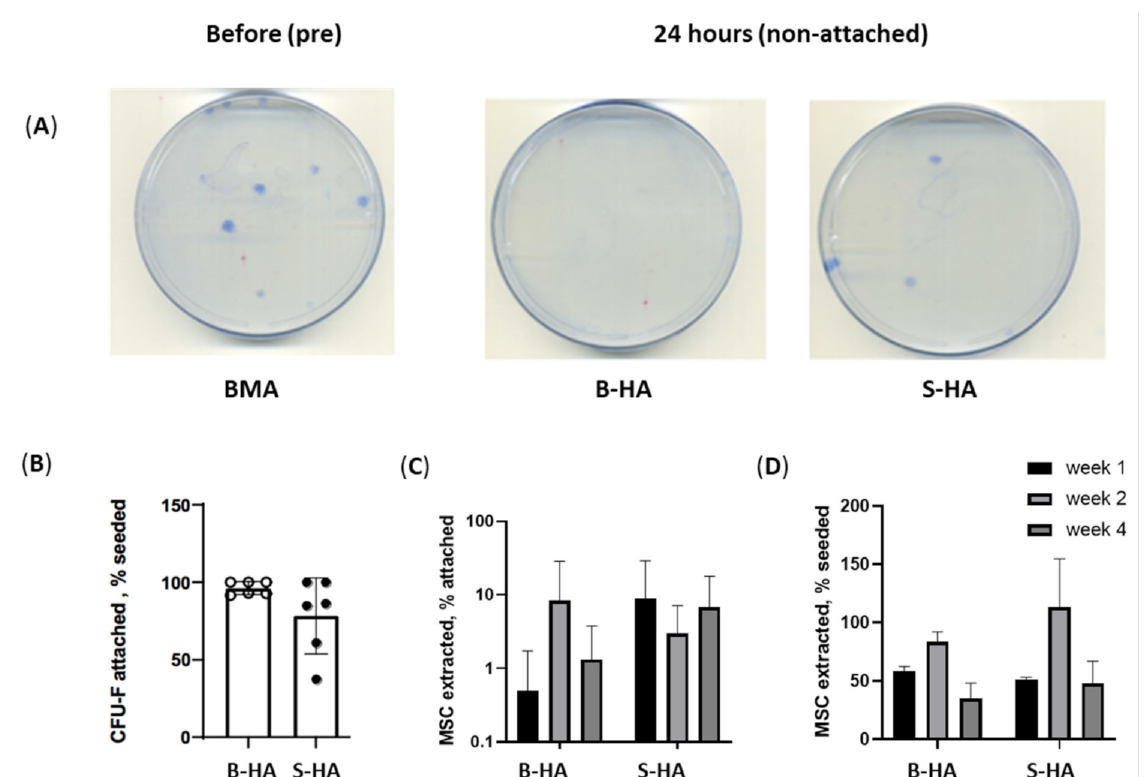
Figure 2. BMSC and cMSC attachment and survival on the scaffolds. ( A ) Examples of BMSC colonies (CFU-F) following the plating of BMA without any scaffolds ( left ), BMSC colonies/CFU-F non- attached on B-HA ( centre ) and S-HA ( right ) after 24 h of adding BMA to the scaffolds. ( B ) BMSC attachment to scaffolds measured as the percentage of attached CFU-Fs to both scaffolds relative to seeded CFU-F; ( C ) BMSC maintenance measured as the percentage of BMSCs extracted after week 1, 2 and 4 of culture; ( D ) cMSC maintenance measured as the percentage of cMSCs extracted after week 1, 2 and 4 of culture using trypan blue for cell counts. Data are shown with mean and standard error of mean and with n = 3 cMSCs and n = 6